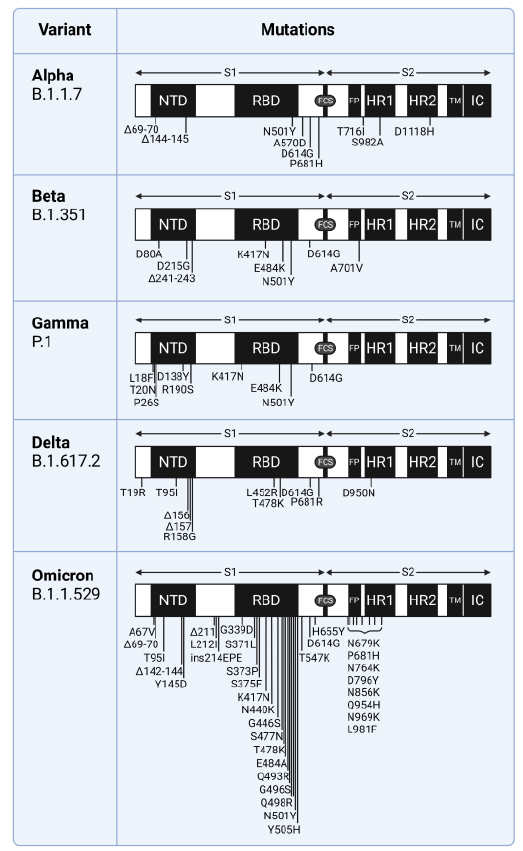
Figure 1. Mutations in the SARS-CoV-2 spike glycoprotein. NTD, N-terminal domain; RBD, receptor binding domain; FCS, furin cleavage site; FP, fusion peptide; HR1, heptad repeat 1; HR2, heptad repeat 2; TM, transmembrane anchor; IC, intracellular tail. The Delta symbol indicates deletion. Mutations as defined by the Centers for Disease Control and Prevention.